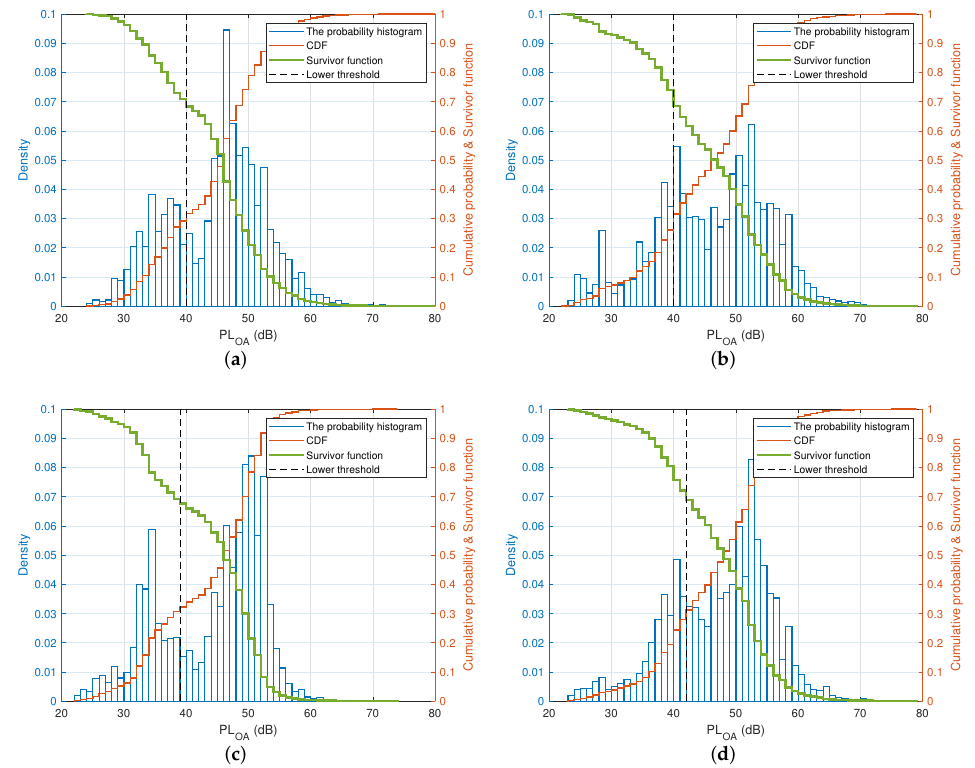
Figure 10. The probability histogram, the CDF, and the survivor function with respect to the lower threshold for the indoor and outdoor experiments. ( a ) Indoor walking (lower threshold = 40 dB); ( b ) indoor jogging (lower threshold = 40 dB); ( c ) outdoor walking (lower threshold = 39 dB); ( d ) out- door jogging (lower threshold = 42